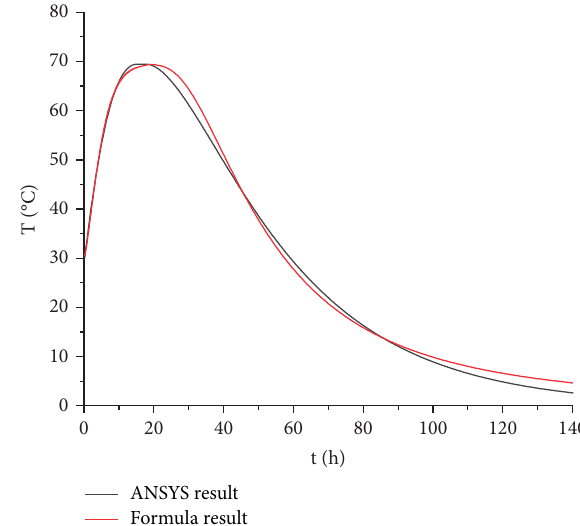
Figure 8: Comparisons of the core temperature calculated by finite element analysis and formula (5) for a 1.5-m diameter CFST.